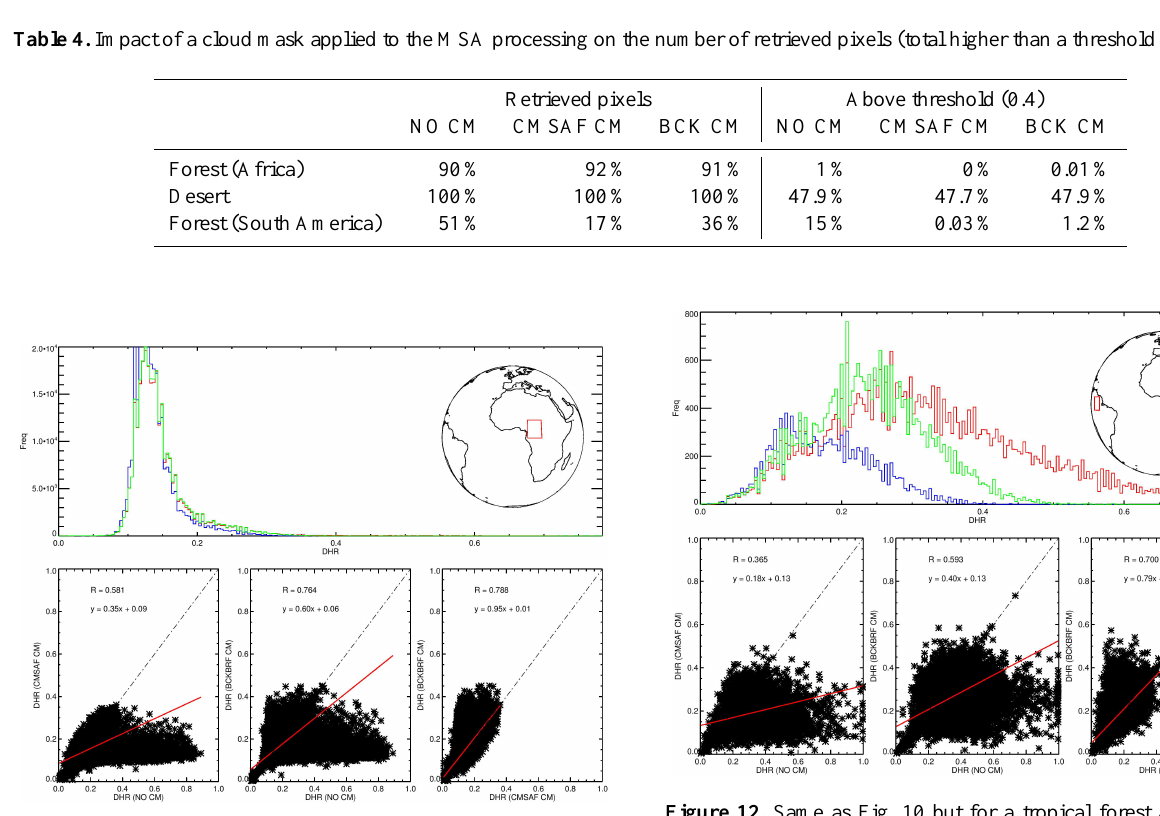
Figure 10. Tropical forest region viewed under a low view zenith angle. Upper panel: distributions of surface albedo retrieved with no cloud mask (NO CM; red), with a single-band (VIS) cloud mask (BCK CM; green), and with the cloud mask developed by the CM SAF (CMSAF CM; blue). Lower panels: scatter plots of albedo es- timates using the cloud mask scheme indicated in the respective x and y axis.